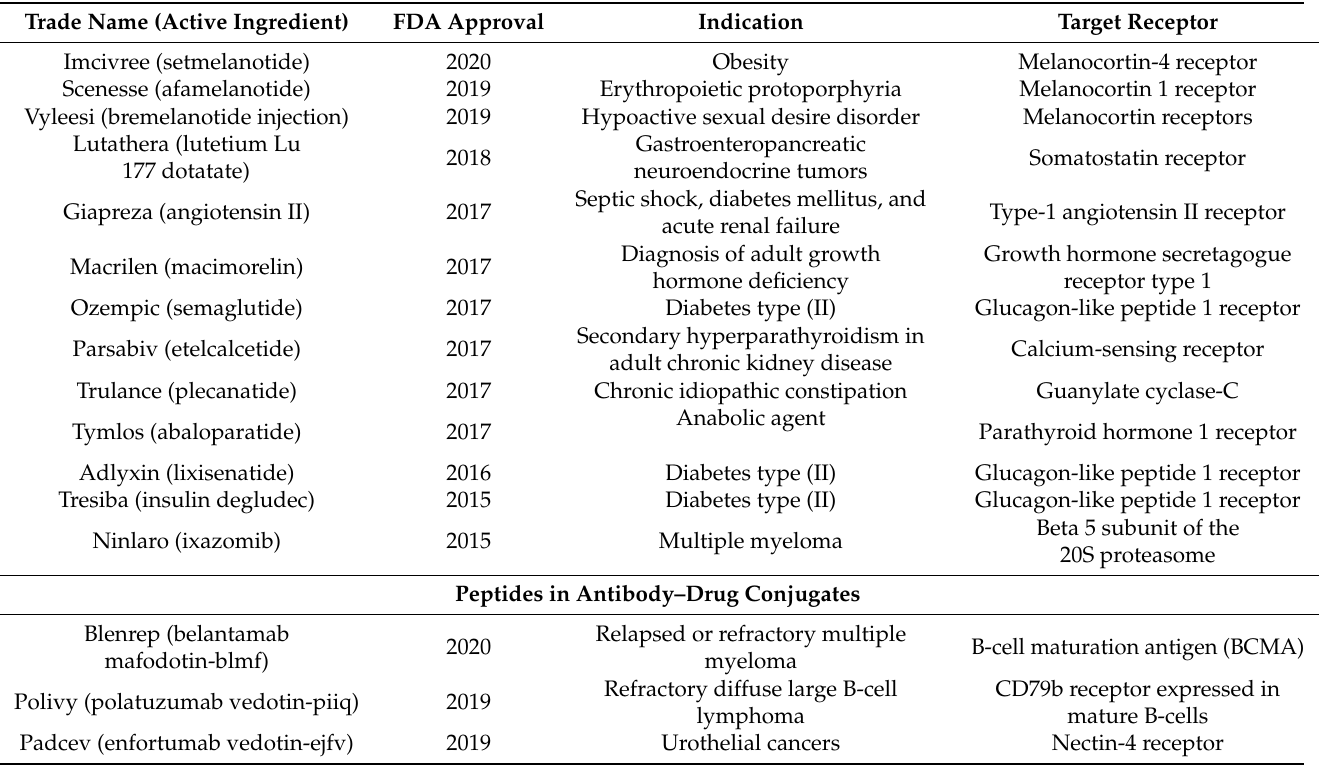
Table 1. FDA-approved peptides and their